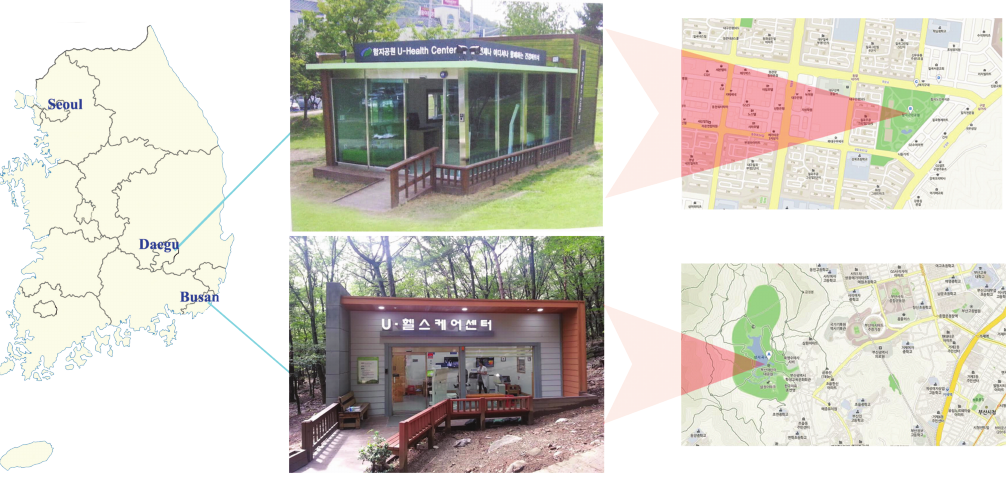
Figure 1. The locations of two U-Healthcare centers with photographs and their surrounding environment